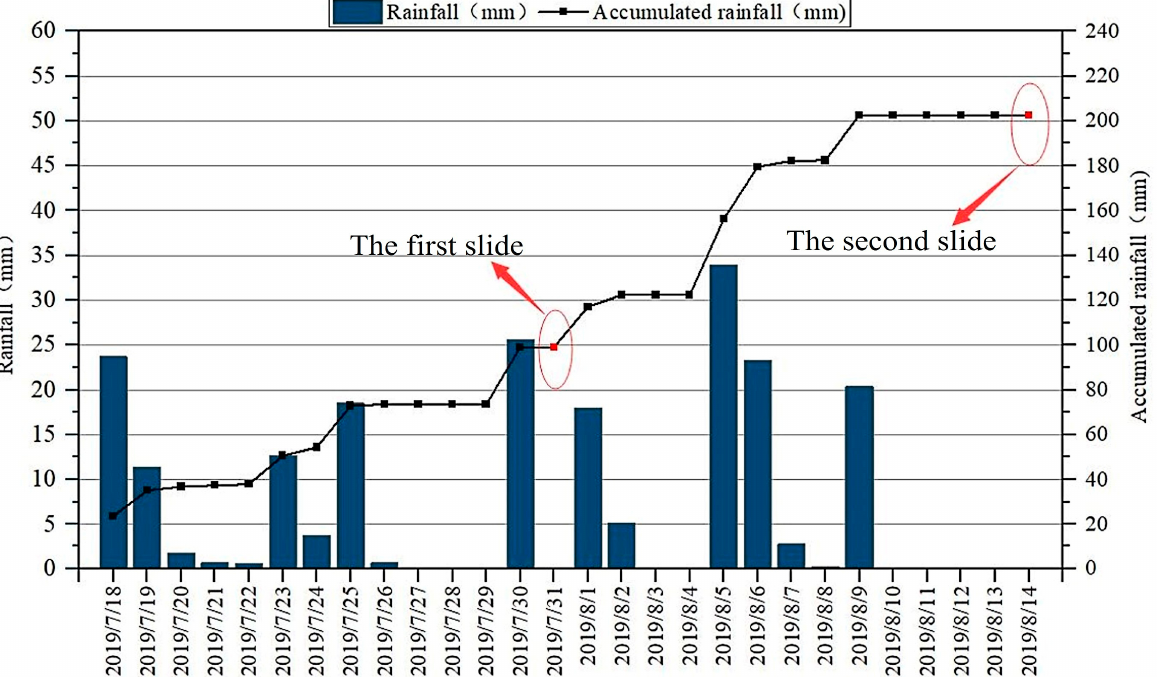
Figure 3. Relationship between rainfall and accumulated rainfall and landslide occurrence.